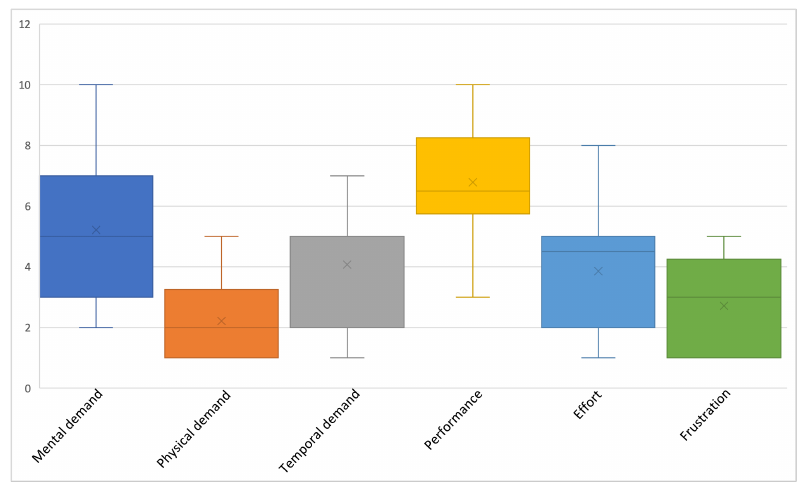
Figure 20. A boxplot of the NASA-TLX result for the exploratory analysis of heterogeneous data use case. Each of the six subscales was captured with a 10-points continuous scale from very low (1) to very high (10) . The X-axis indicates the sub-dimensions of the score. The Y-axis indicates the statistics for each sub-dimension.